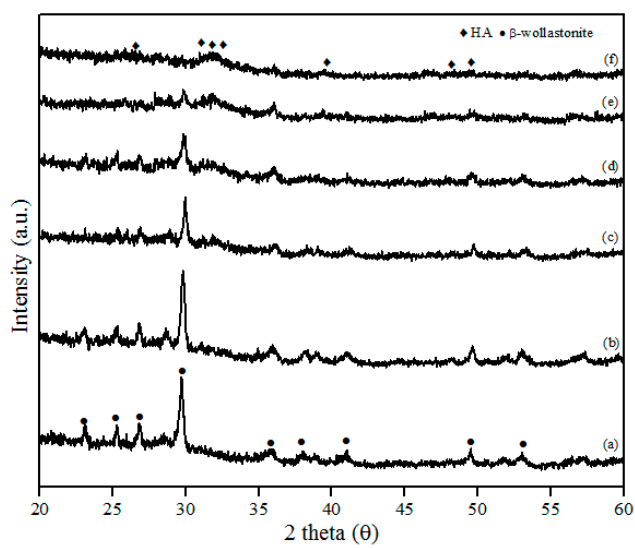
Figure 6. XRD patterns after soaking in the SBF for ( a ) one; ( b ) three; ( c ) five; ( d ) seven; ( e ) 14; and ( f ) 21 days.